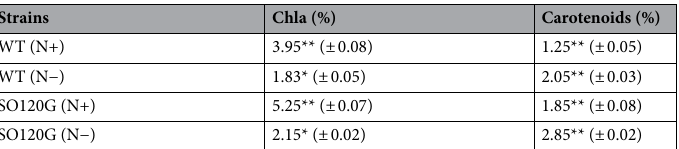
Table 2. The major pigment compositions of S. obliqnus . Values are means (± SD) of n = 3 cultivations per treatment, *represents a significant effect ( p < 0.05), and ** represents a very significant effect ( p <